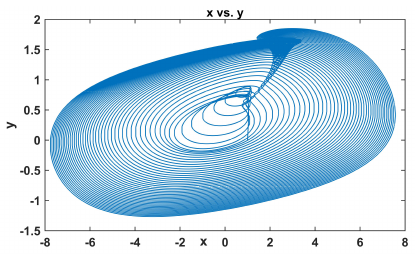
Figure 29. Responses of membrane potential with parameter values a = 0.7, b = 2, c = 3